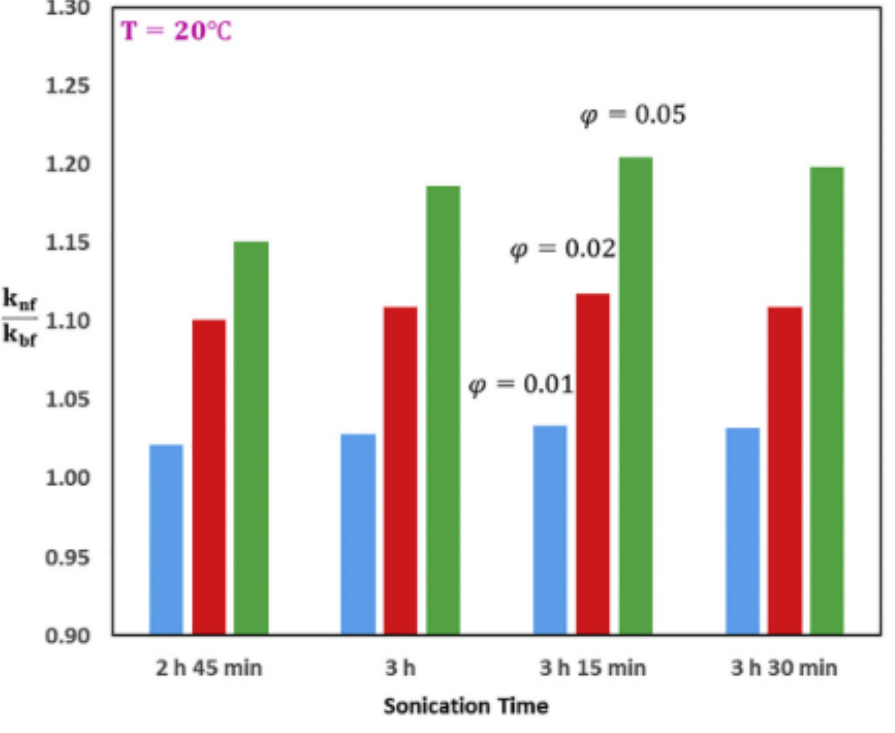
Figure 8. Effect of increasing sonication time and volume fraction on thermal conductivity ration of Al 2 O 3 /paraffin nanofluids at 20 °C [123].